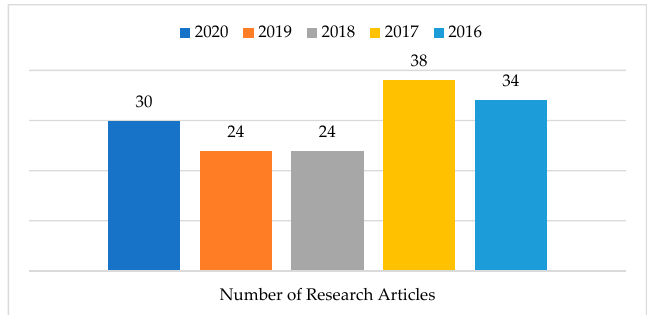
Figure 2. Number of selected research articles per year of publication.